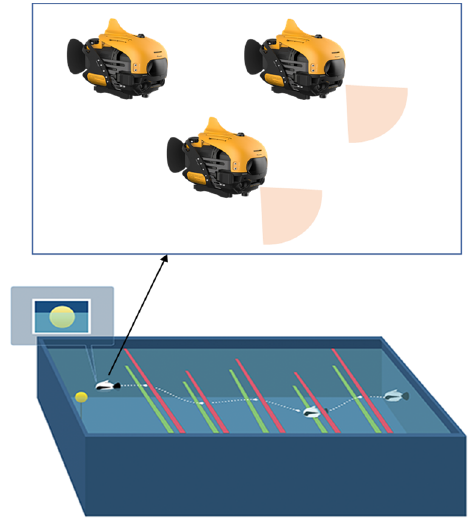
Figure 1. Schematic diagram of swarm game for autonomous underwater robots placed in an artificial water tank. Our experiments are also conducted in a small natural lake to better mimic real applications.